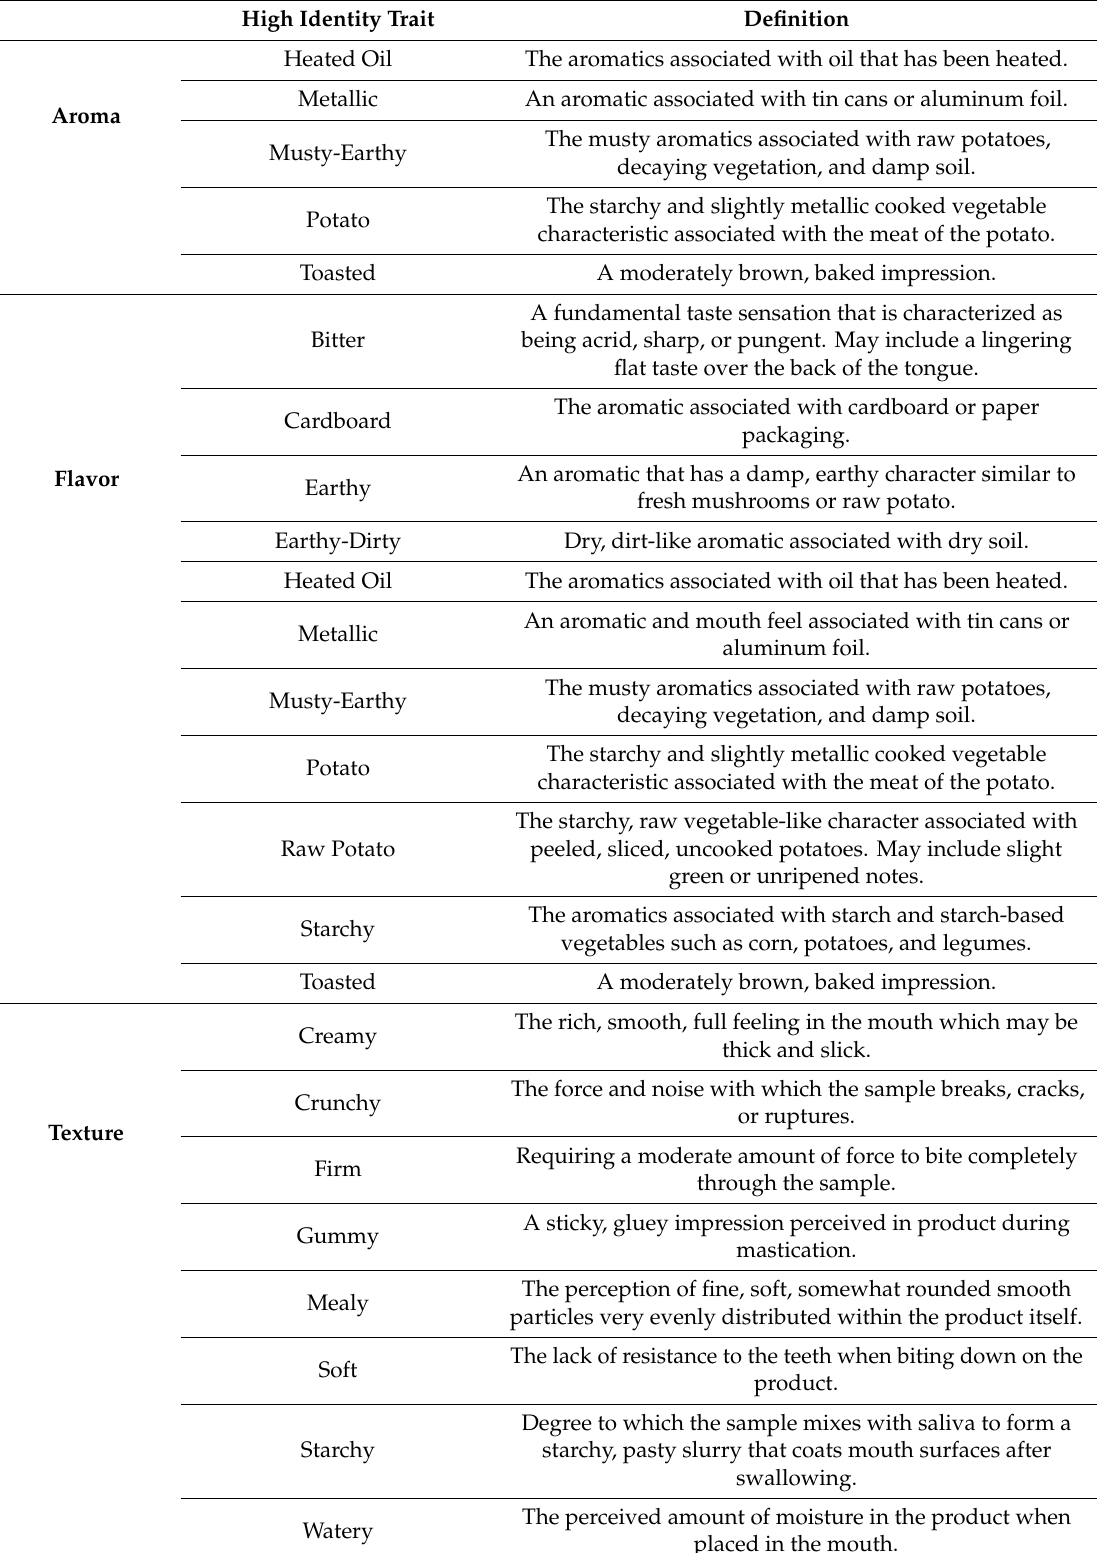
Table 2. Definitions of high identity traits (HITs) used for evaluation of potato